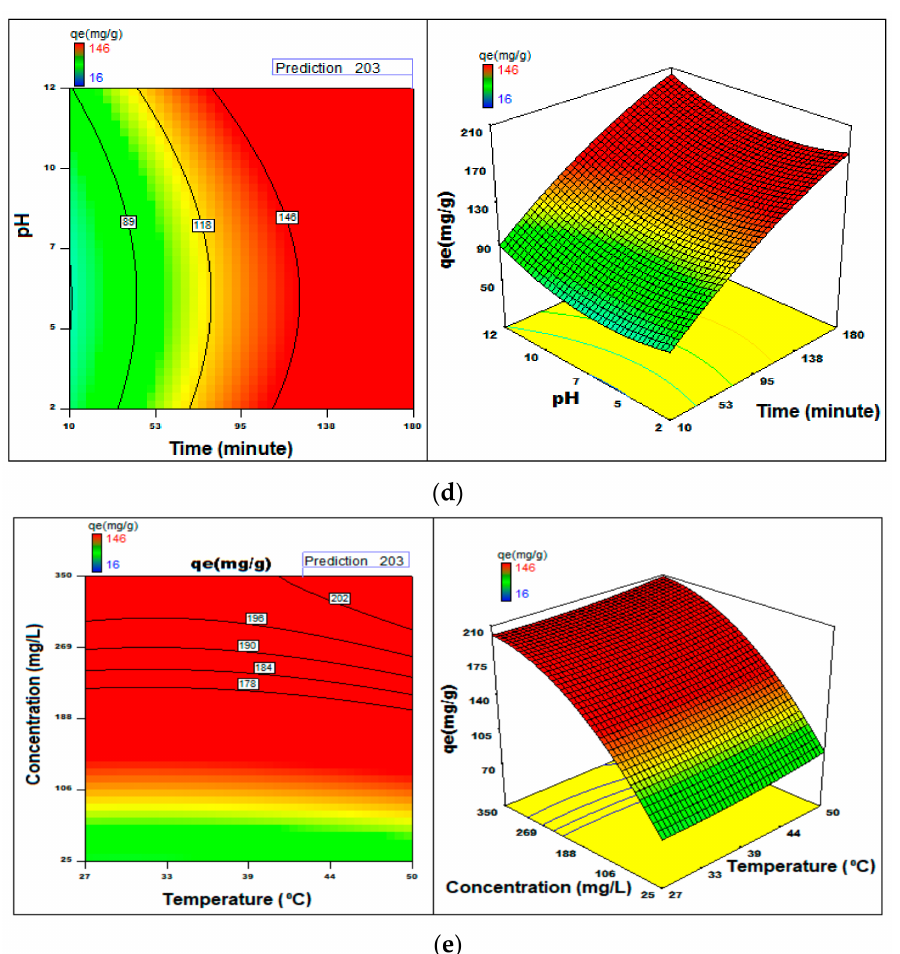
Figure 12. 3D surface plot and contour plot depicting a capacity variation of the adsorption with ( a ) time versus temperature, ( b ) time versus concentration, ( c ) time versus the adsorbent dosage, ( d ) time versus pH, and ( e ) temperature versus concentration.